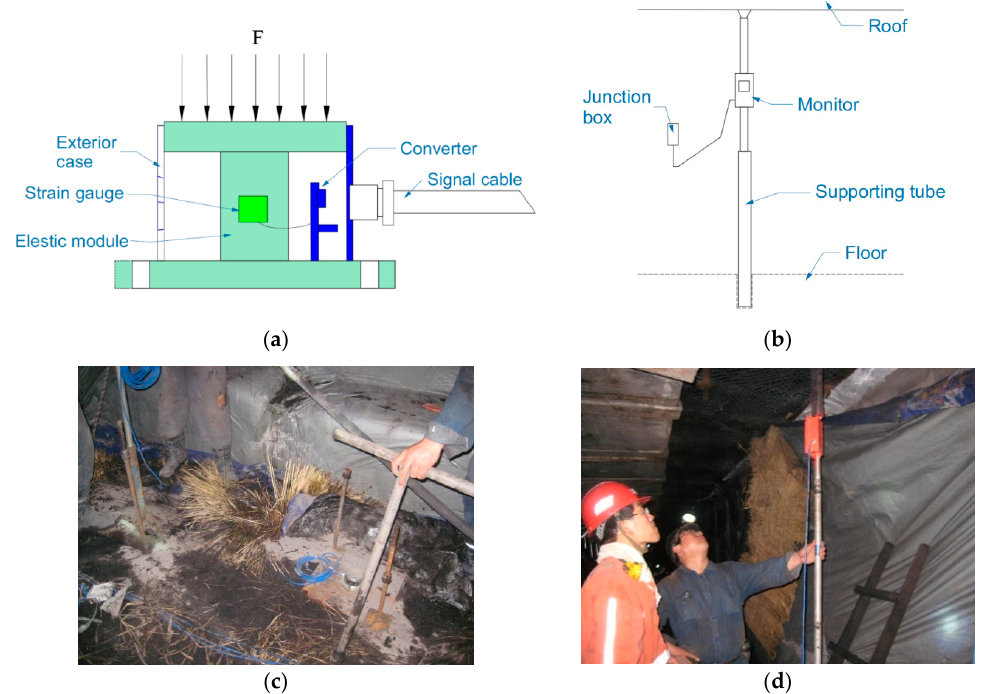
Figure 13. Roof displacement and stress meters. ( a ) Schematic diagram of the stress meter; ( b ) Schematic diagram of the displacement meter; ( c ) Installation of the stress meter; ( d ) Installation of displacement meter.